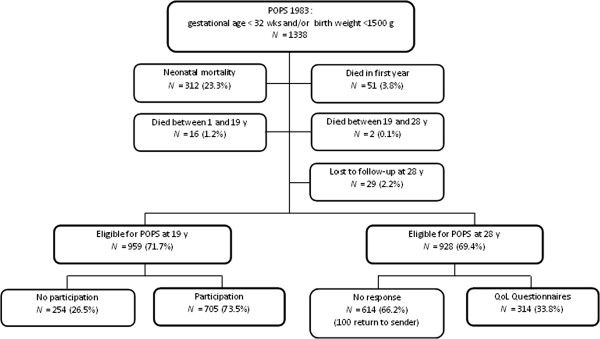
Flow chart inclusion of participants of the POPS study at age 28.